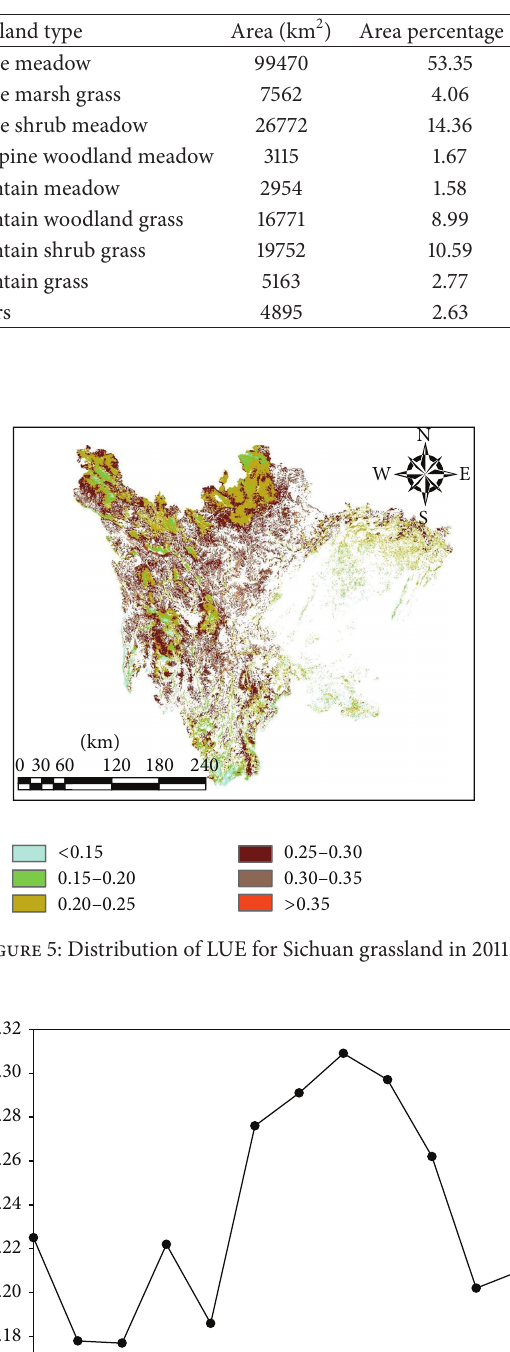
Table 7: Statistics of NPP for different types of Sichuan grassland in 2011.